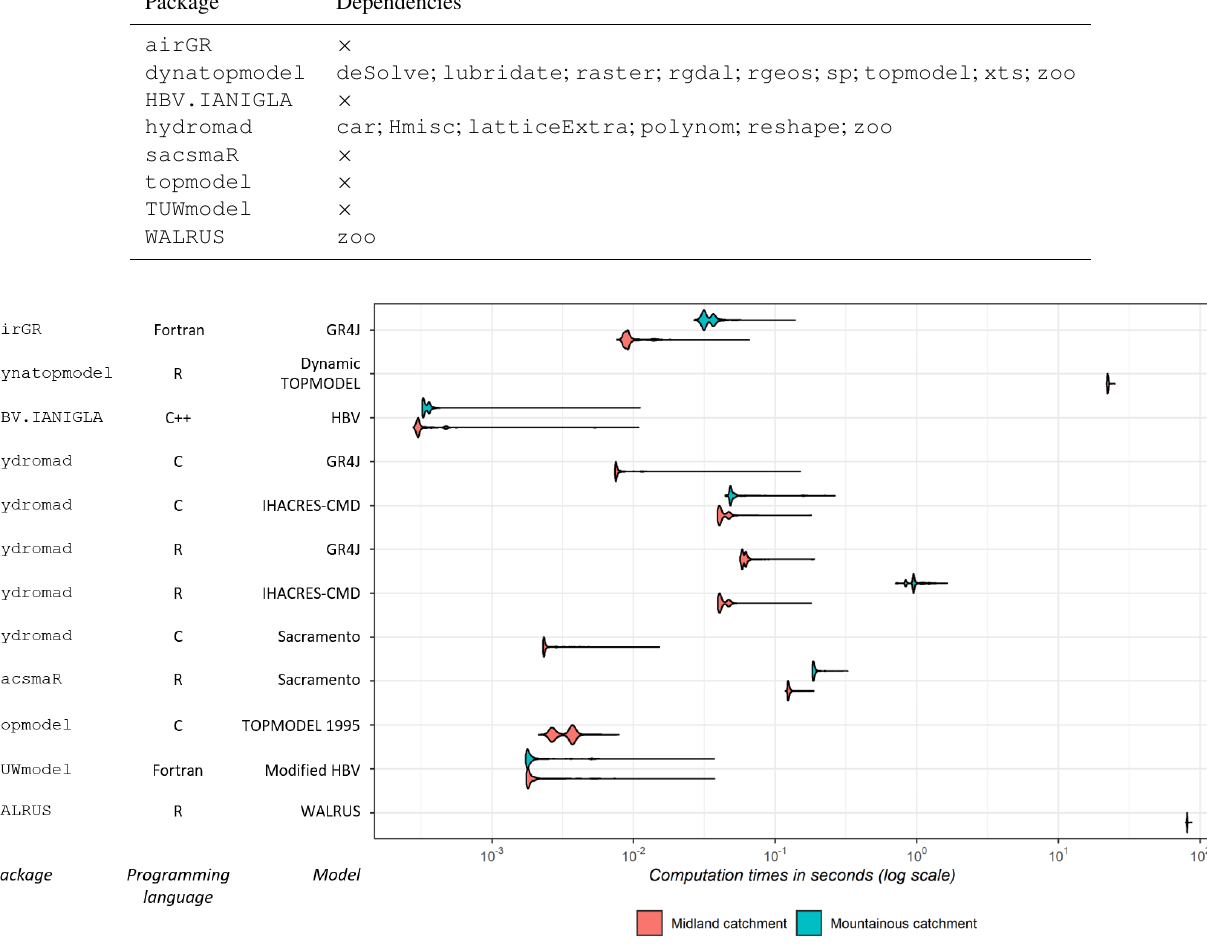
Figure 5. Computation times of the packages (time of one run estimated from 1000 runs using the same parameter set with the microbenchmark package). The models were run on a French catchment, the Meuse river in Saint-Mihiel, and a mountainous catch- ment, the Ubaye river at Lauzet-Ubaye, for a 10-year period at a daily time step. The related package functions were applied using the default settings, i.e. on a single spatial unit, except for dynatopmodel and topmodel . Runs on the mountainous catchment were per- formed only with the packages that integrate a snow function and use the default settings (i.e. five elevation bands for airGR and one for the other packages). hydromad includes an R version and a C version of GR4J and IHACRES-CMD. Data preprocessing and formatting are not taken into account in the estimation of computation times. Computer characteristics are as follows: RAM capacity – 8.00GB; CPU –